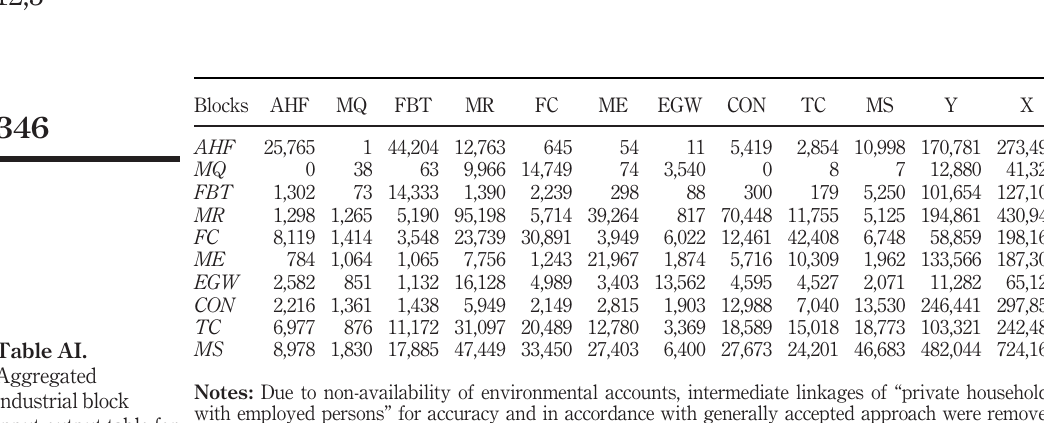
industrial block input-output table for 2009 (millions of